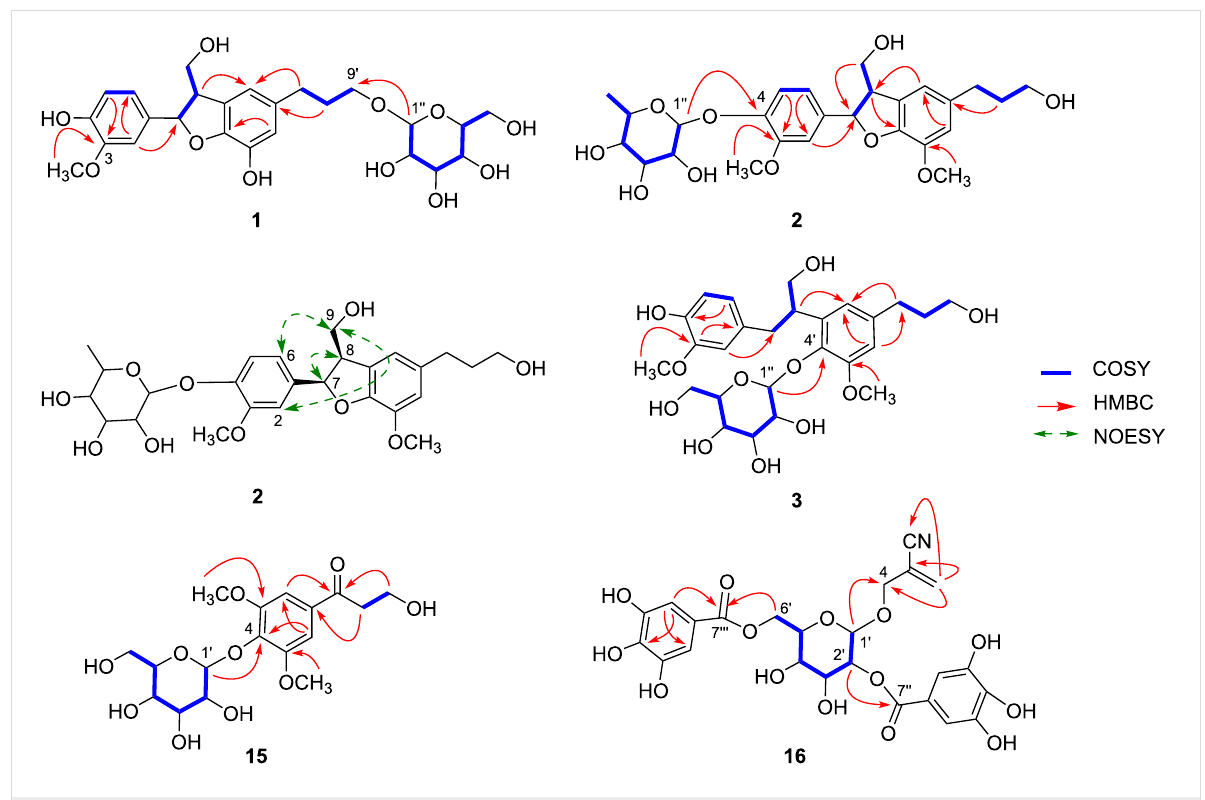
Figure 2: Key COSY and HMBC correlations of compounds 1 – 3 , 15 , and 16 and key NOESY correlation of 2 .